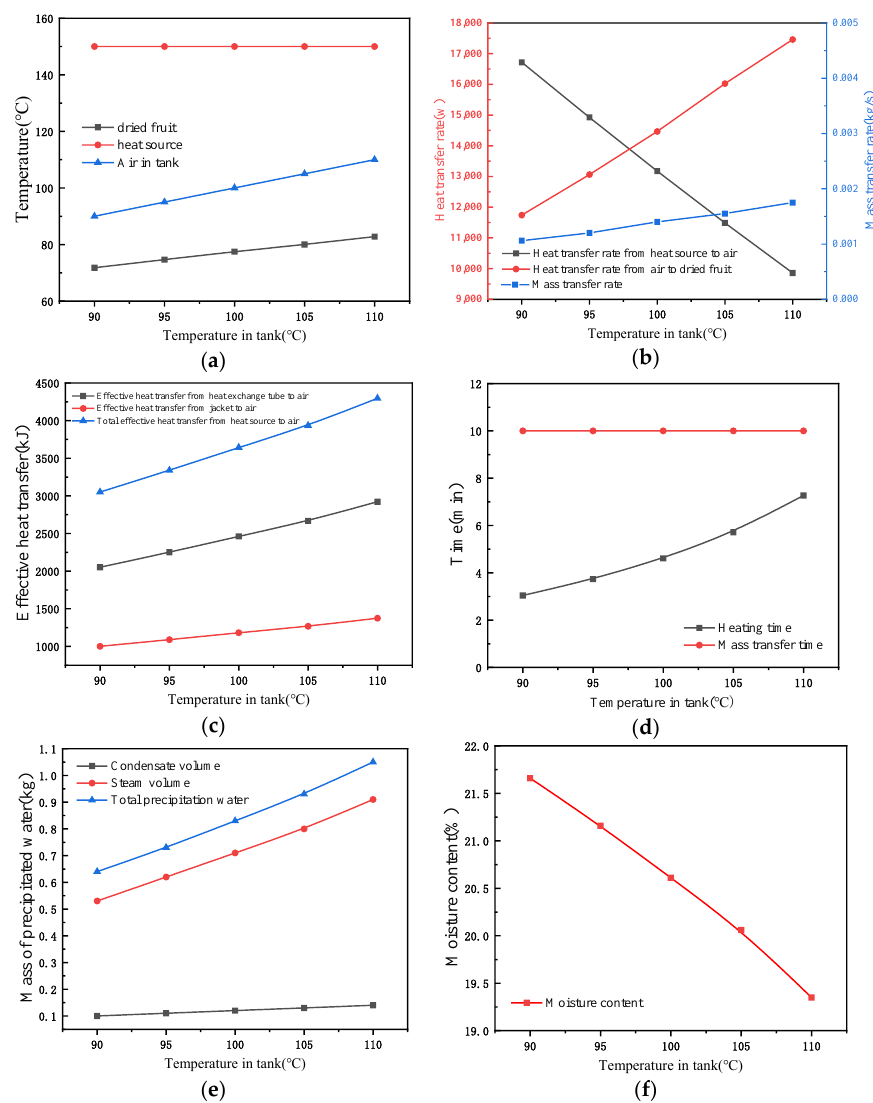
Figure 2. Effect of temperature in tank on heat and mass transfer performance. ( a ) Temperature changes in the tank; ( b ) Influence of temperature in tank on heat and mass transfer power; ( c ) Effect of temperature in tank on heat transfer; ( d ) Effect of tank temperature on heating time; ( e ) Influence of temperature in tank on precipitation and condensation water; ( f ) Effect of temperature in tank on moisture content of dried